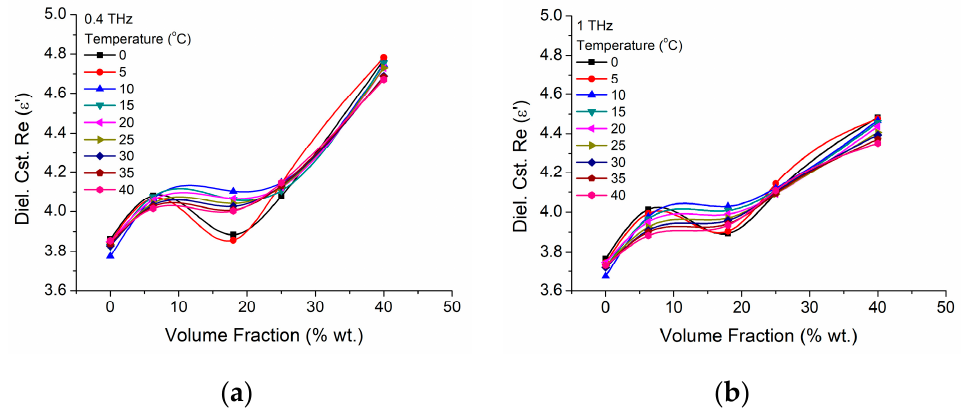
Figure 5. BTO-Gelatin dielectric constant ε ’ variation with particle concentration volume fraction variation at ( a ) 400 GHz and ( b ) 1 THz and different temperatures.